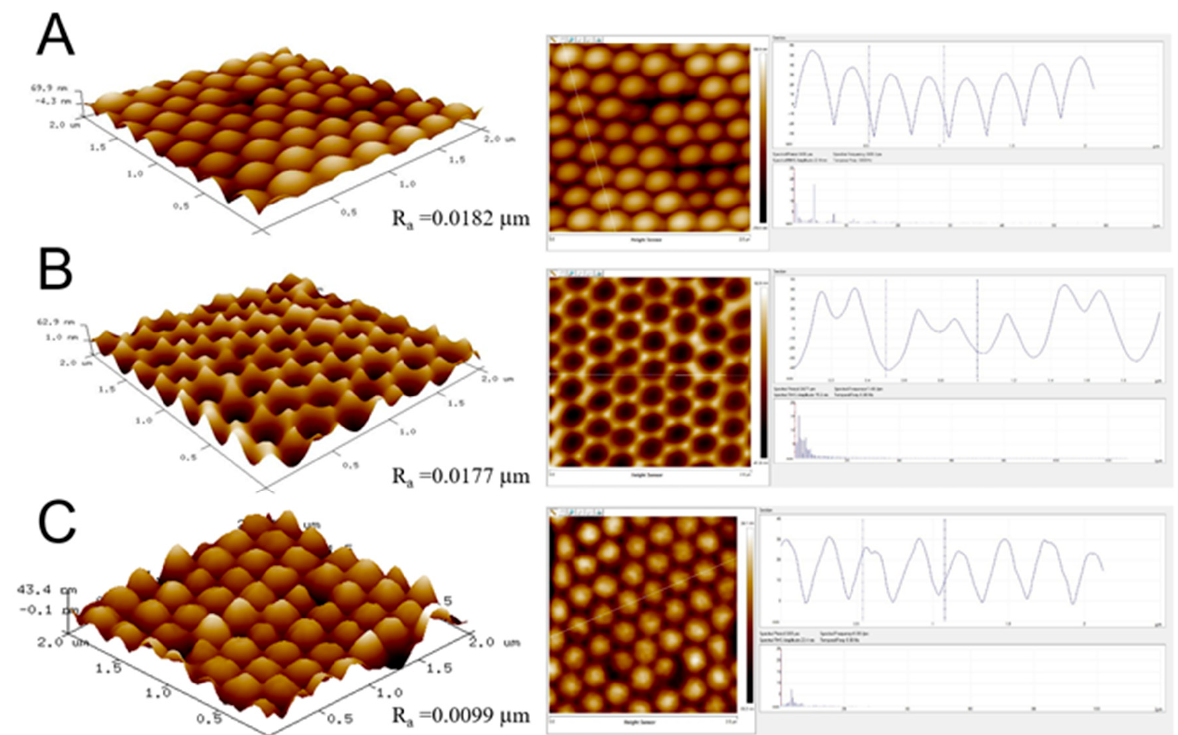
Figure 7. Atomic force microscopy (AFM) surface profiles of ( A ) an assembled 300 nm nanosphere array, ( B ) a replicated soft mold, and ( C ) an embossed nanofeatured film.